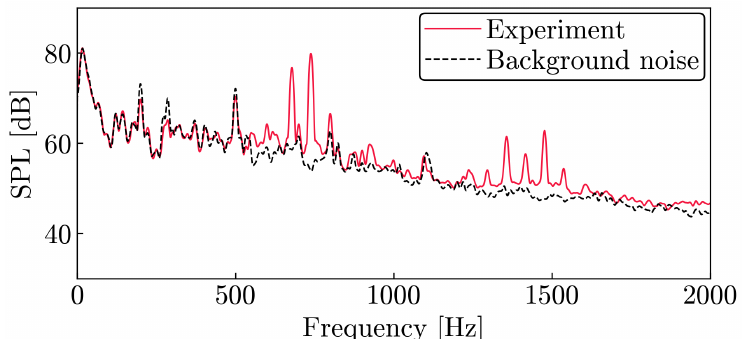
Figure 4. Sound pressure level proved by a microphone at ( r , θ ) = ( 750 mm, π /2 ) .